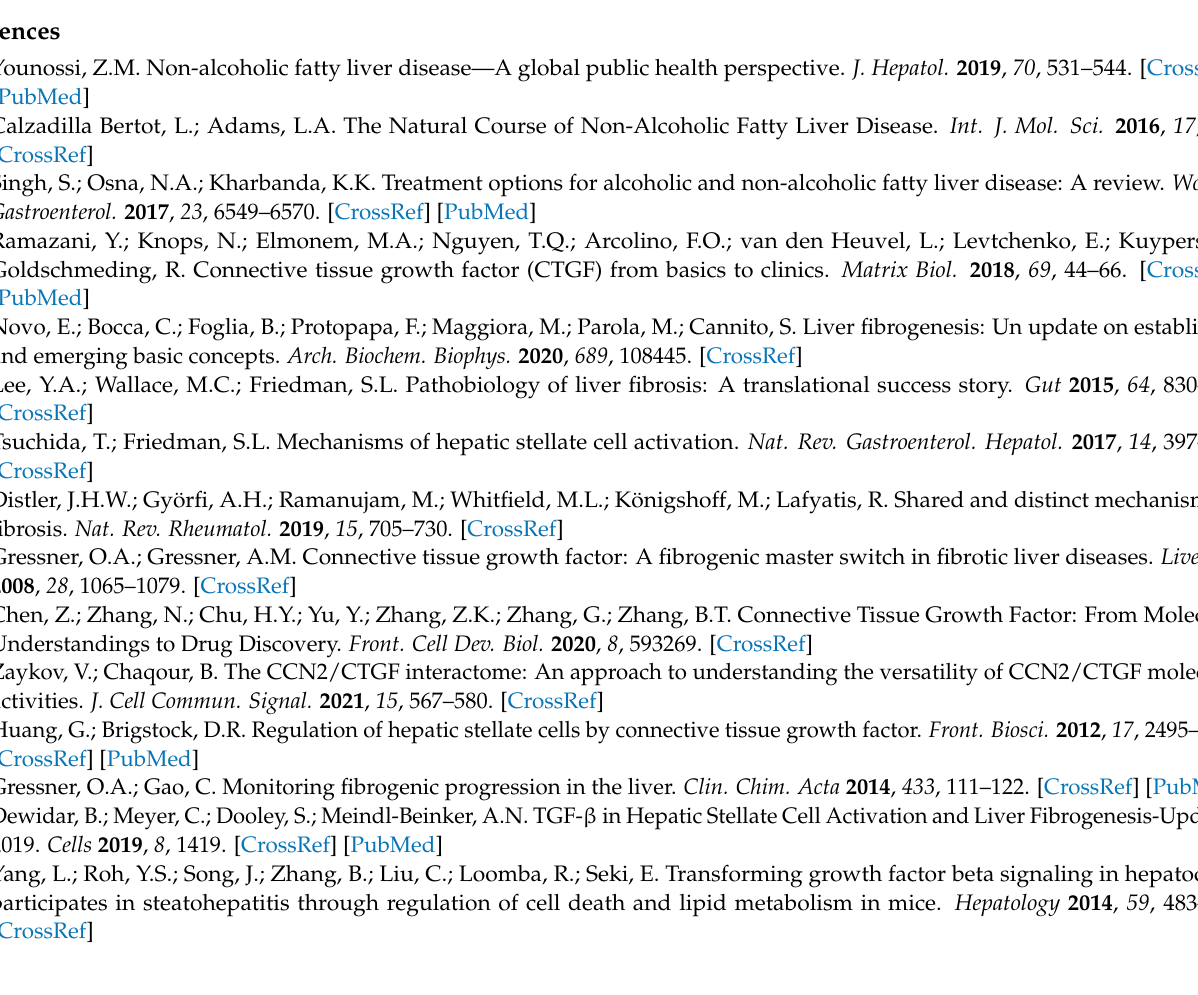
functionality; Figure S3: Angiotensin II-induced CTGF expression and production; Table S1: TaqMan probes used for RT-PCR; Table S2: List of the used